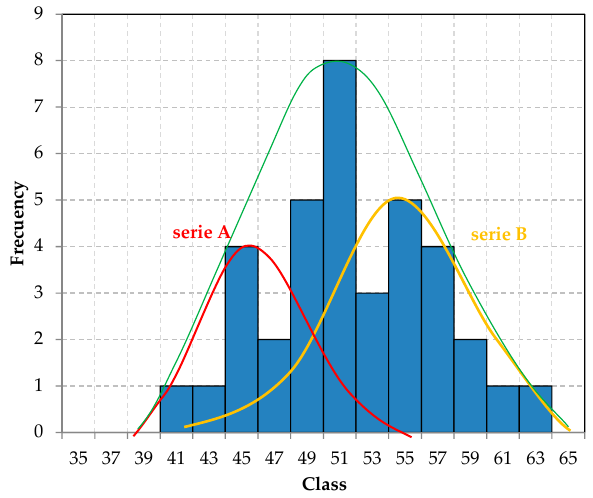
Figure 10. Histogram for MOR c values of the total samples.